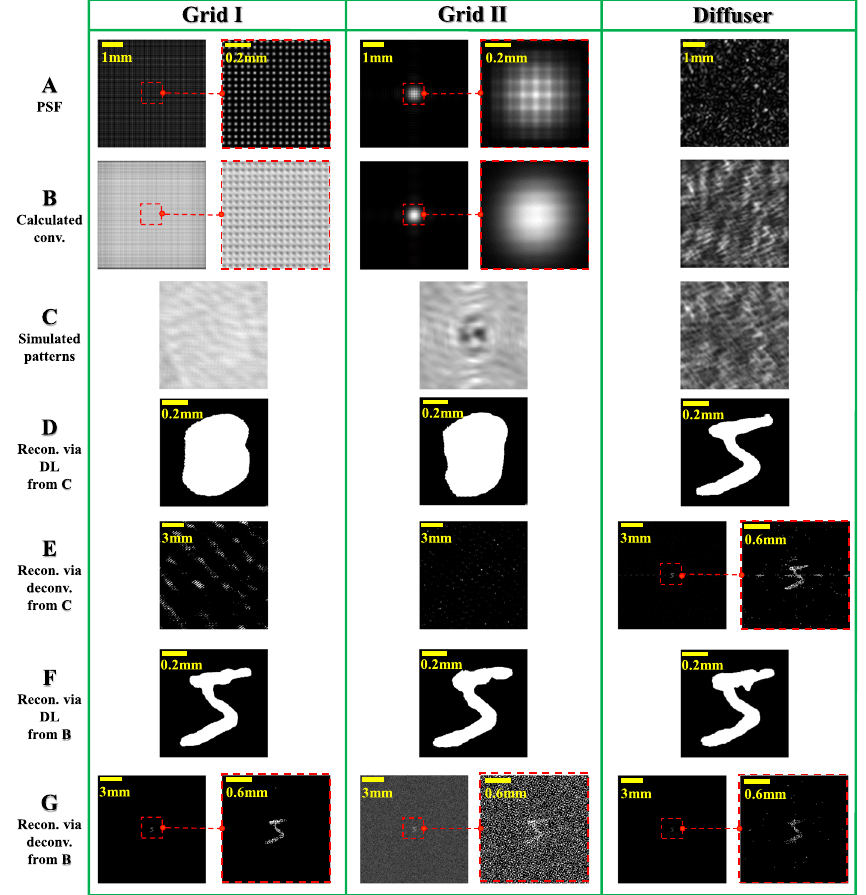
Fig. 4 Corresponding simulation results of grid and diffuser channels under incoherent illumination. No image can be reconstructed from recorded patterns by either deep learning or deconvolution for both grids. There is no valid channel in phase-grids to transmit information, although the system constructed by it is shift-invariant. Row A: the PSFs of different systems (Grid I, Grid II, and diffuser). Row B: the calculated convolution of digit “5” and the corresponding PSFs. Row C: the corresponding recorded patterns by the camera. Rows D: images extracted from Row C via deep learning. Row E: images from Row C via deconvolution. Rows F: images from Row B via deep learning. Row G: images from Row B via deconvolution. The red dash square inserts show the zoom-in of original areas correspondingly,